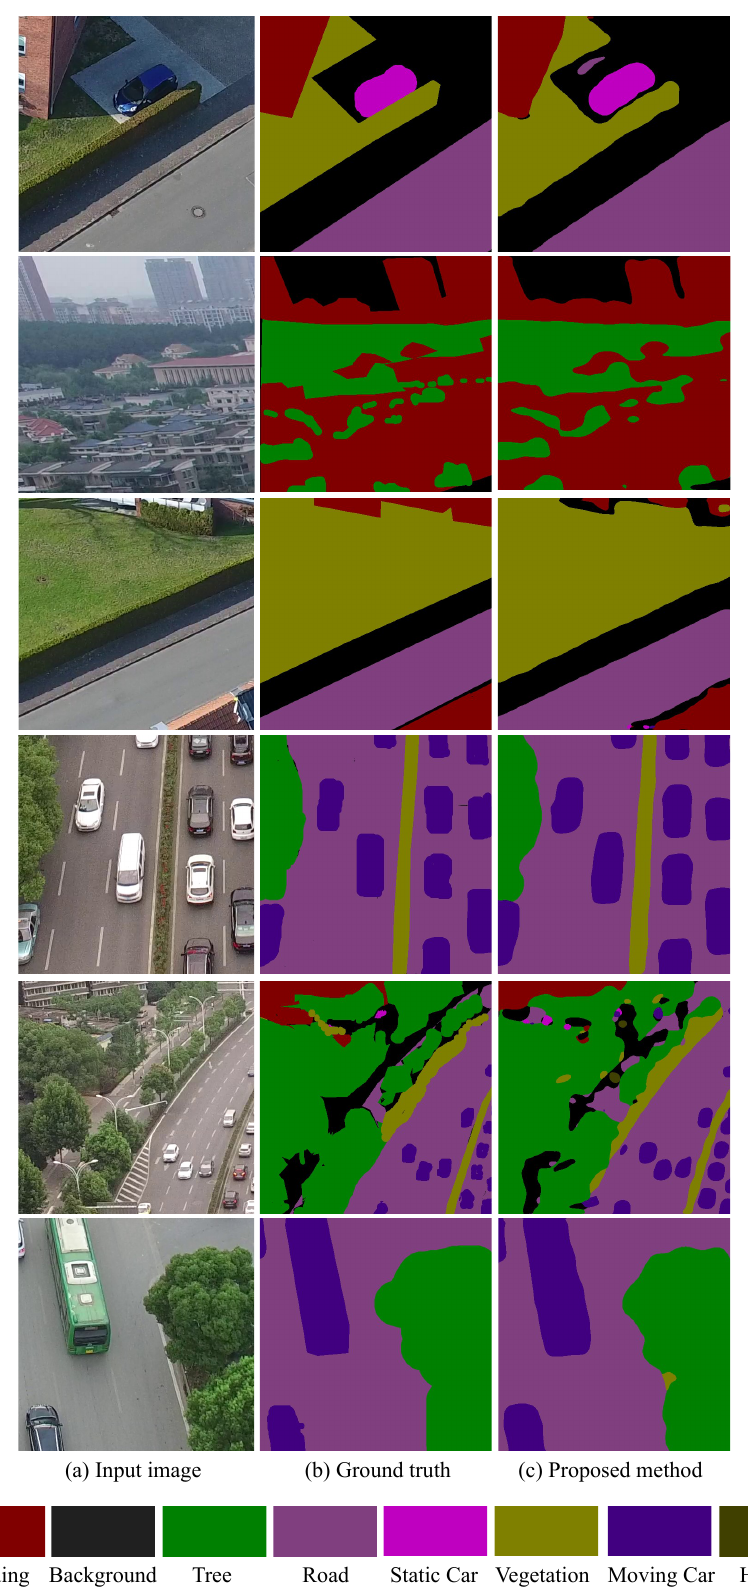
Figure 4. Qualitative prediction results using the UAVid validation